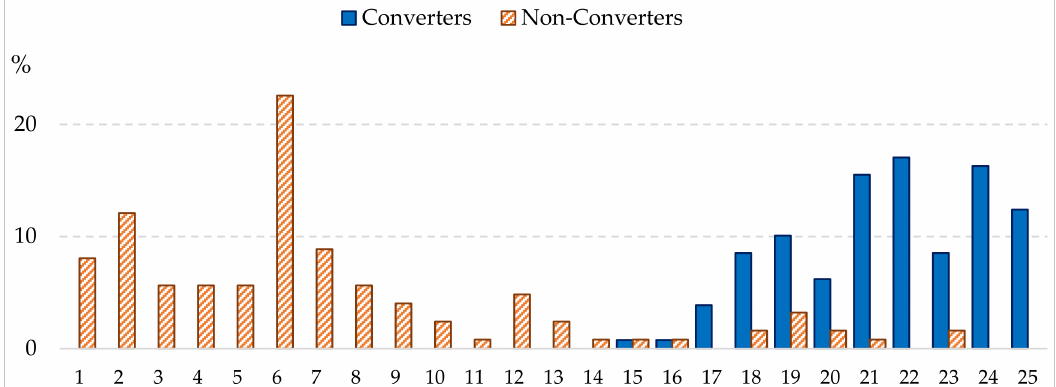
Figure 4. Percentage of households implementing different numbers of designated HPRS practices in northern Thailand.